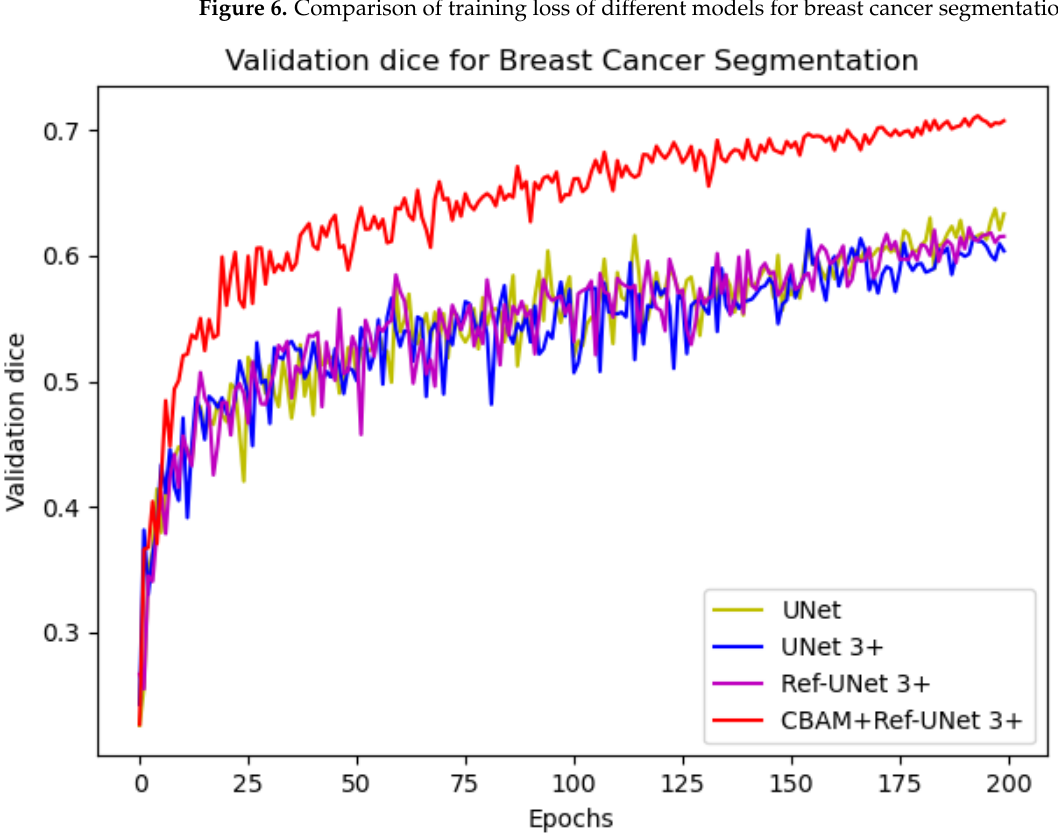
Figure 7. Comparison of validation dice of different models for breast cancer segmentation.